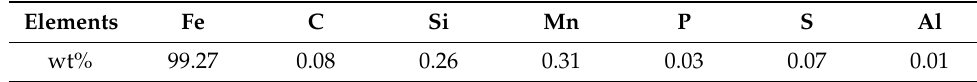
Table 1. Chemical composition of steel substrate.